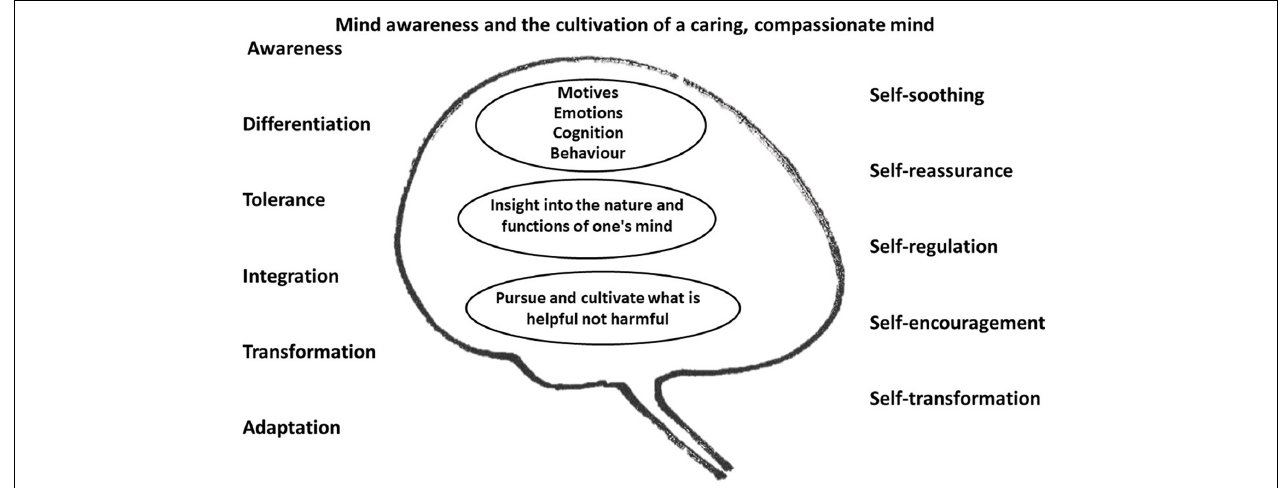
FIGURE 3 | Core processes of change. ©Paul